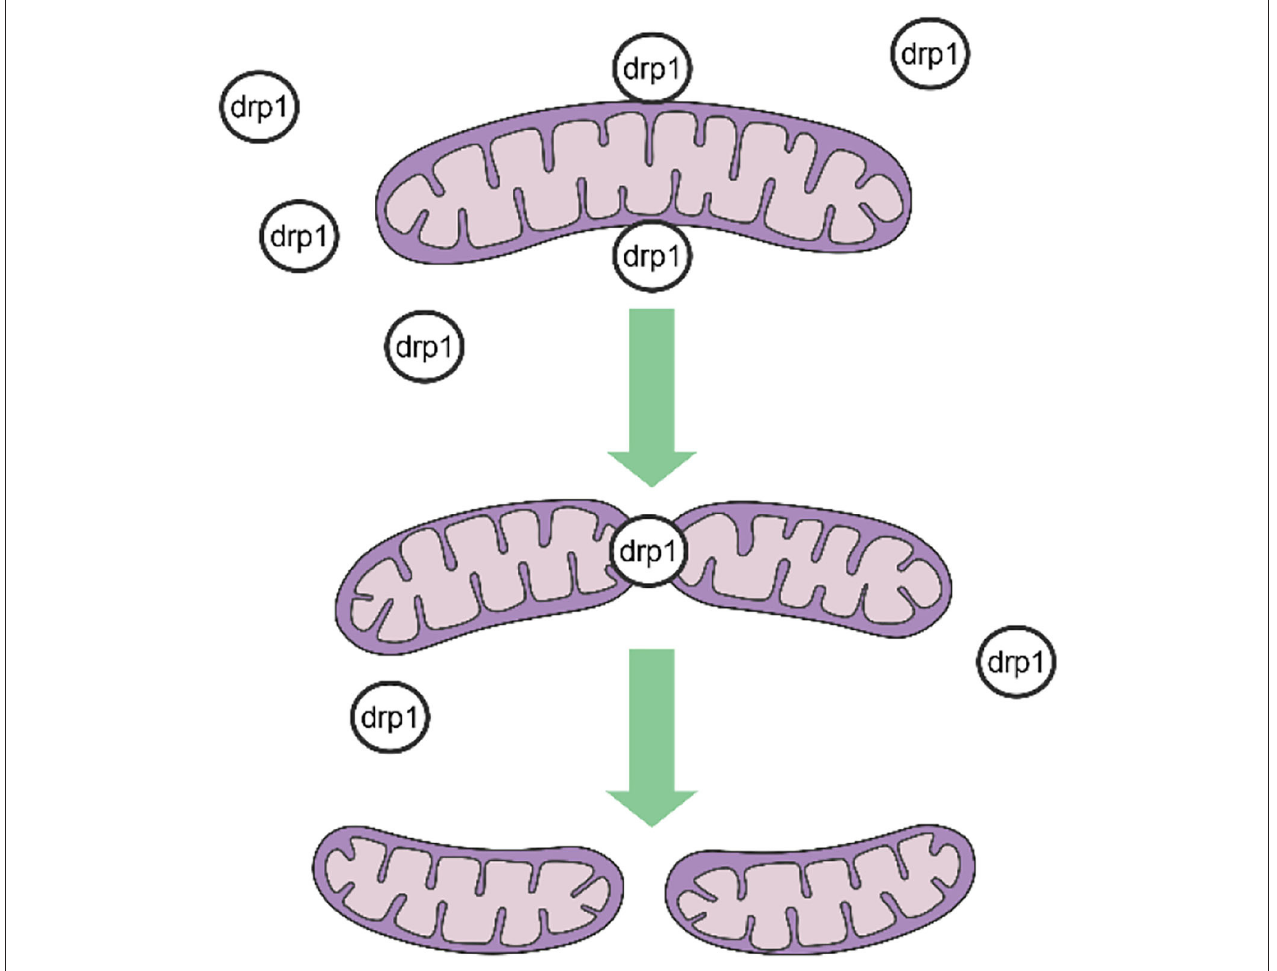
FIGURE 1 | Procedures of mitochondrial